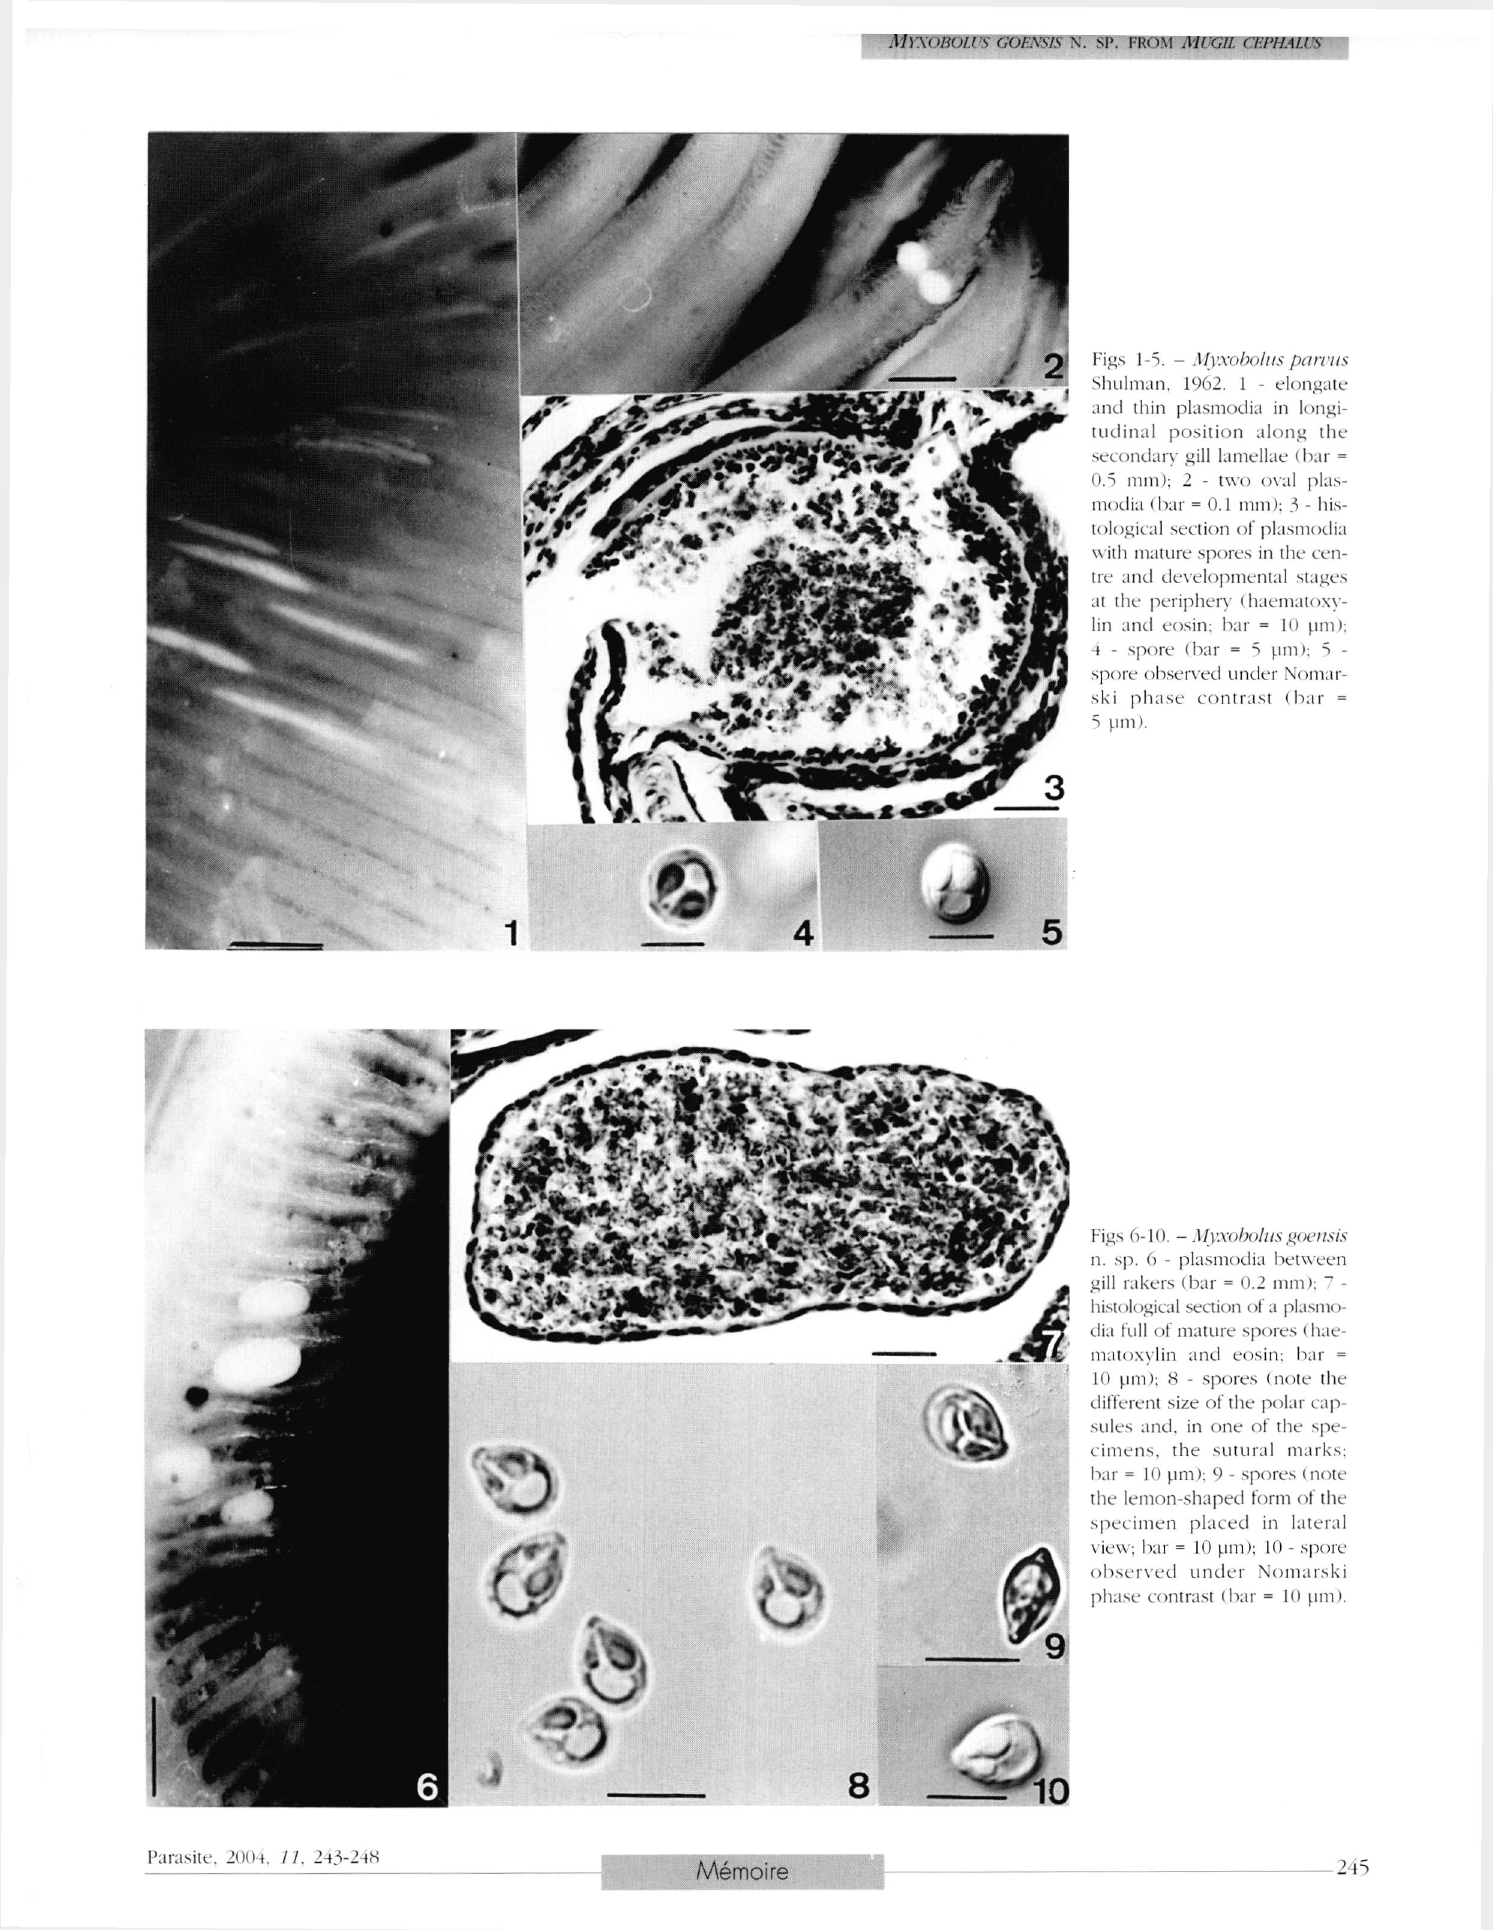
Figs 6-10. - Myxobolus goensis n. sp. 6 - plasmodia between gill rakers (bar = 0.2 mm): 7 - histological section of a plasmo­ dia full of mature spores (hae- matoxylin and eosin; bar = 10 um): 8 - spores (note the different size of the polar cap­ sules and. in one of the spe­ cimens, the sutural marks; bar = 10 um); 9 - spores (note the lemon-shaped form of the specimen placed in lateral view; bar = 10 um); 10 - spore observed under Nomarski phase contrast (bar = 10